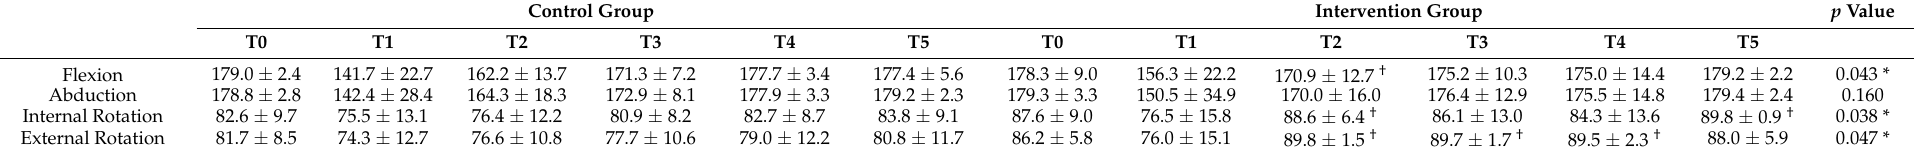
Table 2. The values in range of motion of shoulder. Control Group